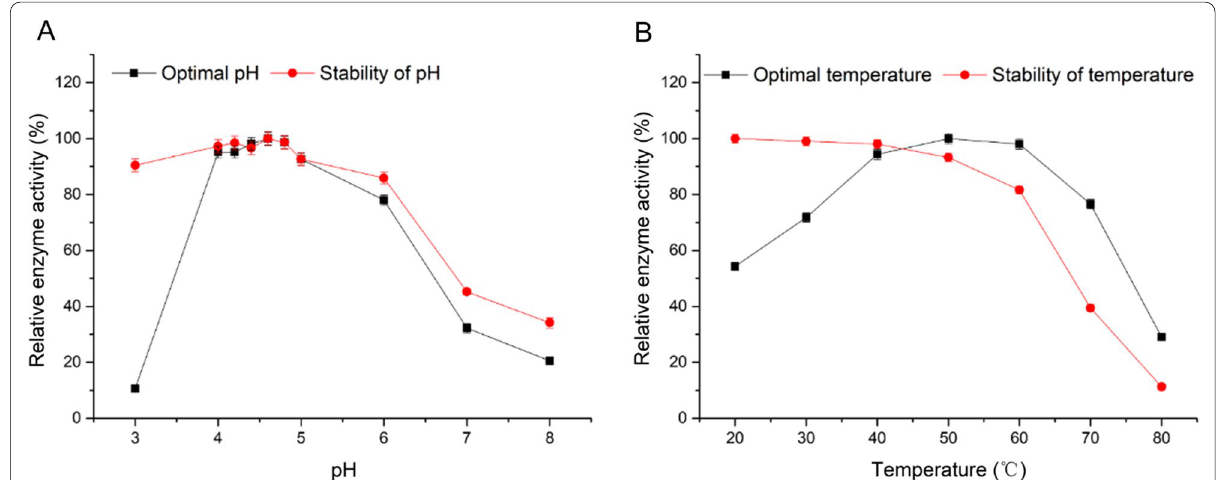
Fig. 2 Effects of pH A and temperature B on recombinant α-L-rhamnosidase N12-Rha.